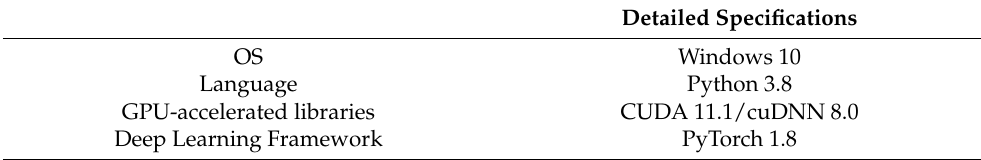
Table 2. Software Specifications.